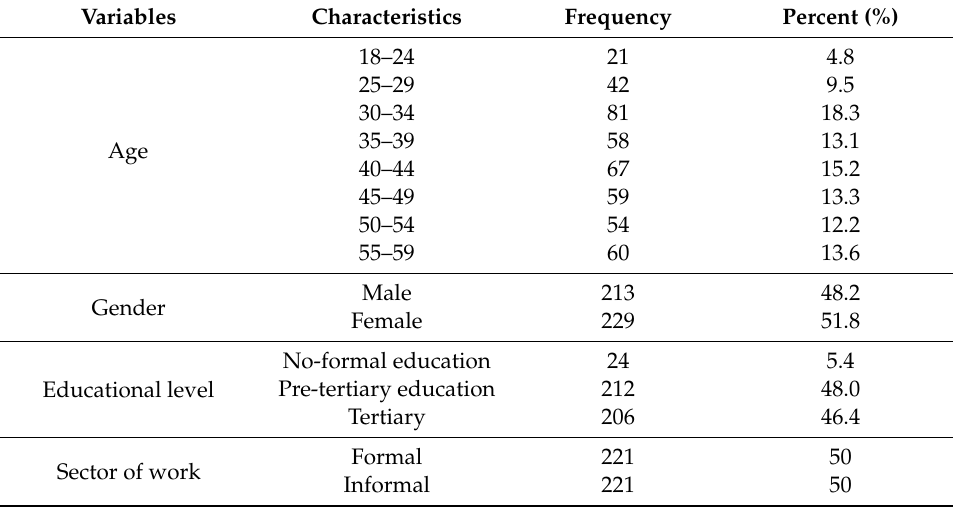
Table 3. Respondent